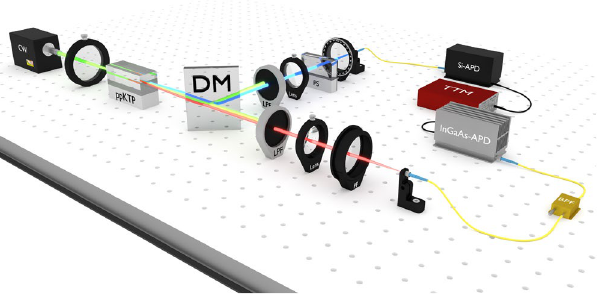
Figure 4. Experimental setup. A 532.3 nm continuous-wave laser pumps a ppKTP crystal with periodicity Λ = 63.1 μ m, length L = 10 mm and temperature T = 60.0 °C to generate photon pairs at λ = 1293.9 nm, both in horizontal and vertical polarisation. A dichroic mirror (DM) separates the generated λ R pairs according to their wavelength. Longpass filters (LPF) in both arms are used to remove the pump light. A phase shifter (PS), realised by a pair of calcite wedges in the 904.3 nm arm, allows us to tune the phase angle θ and to compensate for the different relative group delays of the two superimposed photon pairs. After going through a rotatable polarisation filter (PF) the photons are coupled into single-mode fibres. A fibre-coupled, tunable bandpass filter (BPF) of 0.9 nm width, limits the bandwidths of the horizontal and vertical 1293.9 nm photons. We used a silicon avalanche photo diode (Si-APD, η det ≈ 0.38) and an indium gallium arsenide (InGaAs) APD ( η det ≈ 0.12) to detect the 904.3 nm and the 1293.9 nm photons respectively. A time-tagging module (TTM) was used to count the coincidences within a time window of 2 ns. (Image © Alexander Sanchez de la